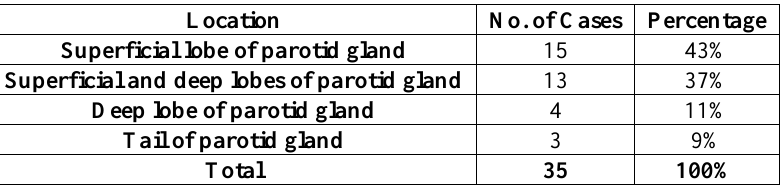
Table 5: Types of surgical